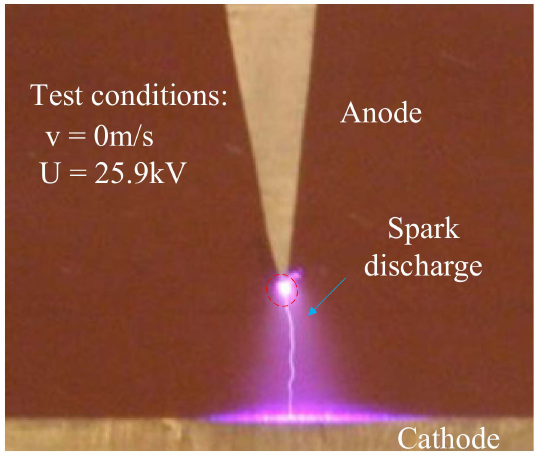
Figure 6. Image of discharge along the surface at an applied voltage of 25.9 kV without airflow.